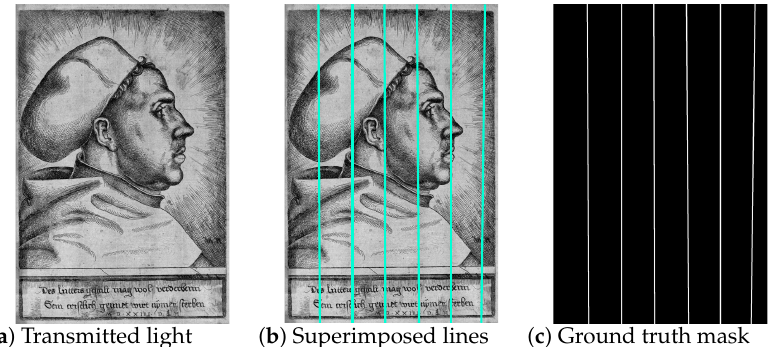
Figure 6. Illustration of the line annotation ( a ) in the transmitted light images of historical prints by ( b ) selecting start and end points of the lines and ( c ) computing the corresponding mask images. Image: ( a ) Daniel Hopfer, Martin Luther with the doctor’s cap , Etching, Germanisches Nationalmuseum Nürnberg, K722; captured by Thomas Klinke; all rights reserved by the respective